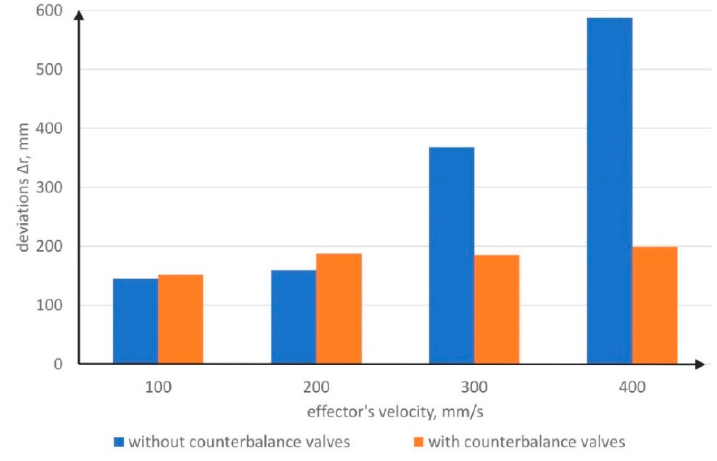
Figure 19. Manipulator effector deviation range, Δ r, for different speeds of movement.